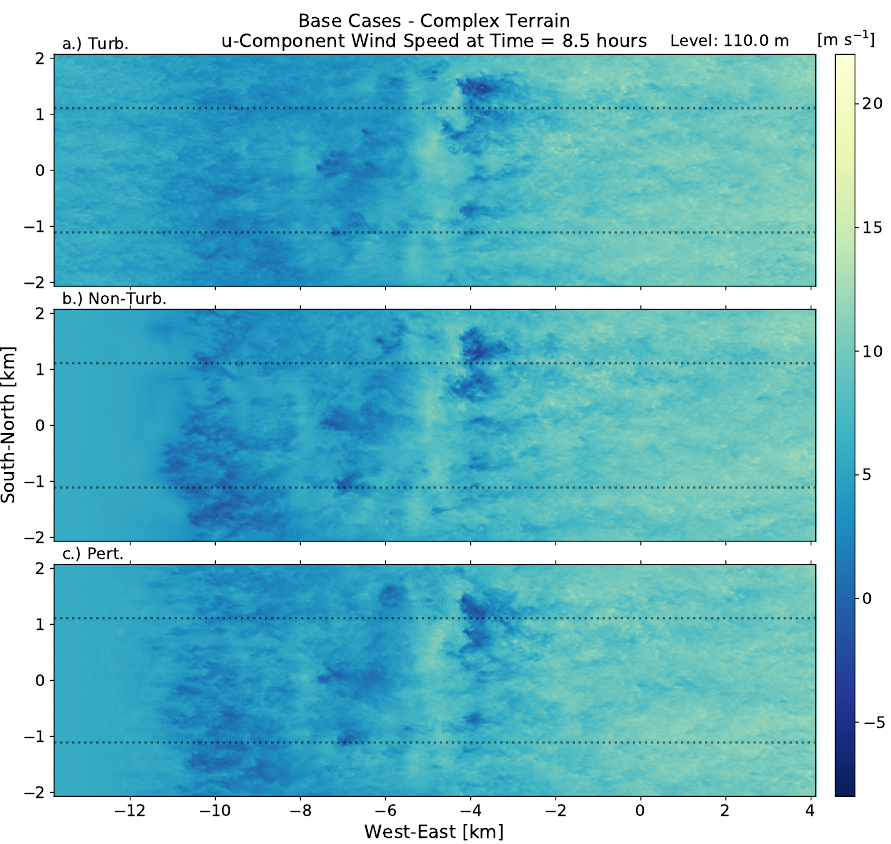
Figure 4. Horizontal slice of u -component wind speed at z = 110 m for the ( a ) turbulent, ( b ) non-turbulent, and ( c ) cell perturbation simulations in the CXT_base cases at 4.5 h into the terrain simulation. Dotted black lines denote the analysis domain as referenced in Figure